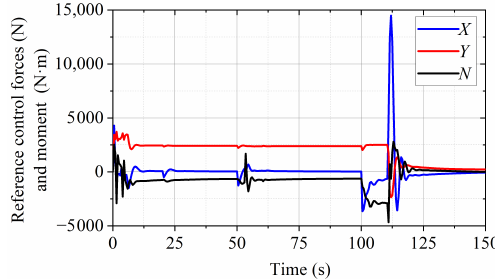
Figure 14. Reference control vectors in the sideway movement.